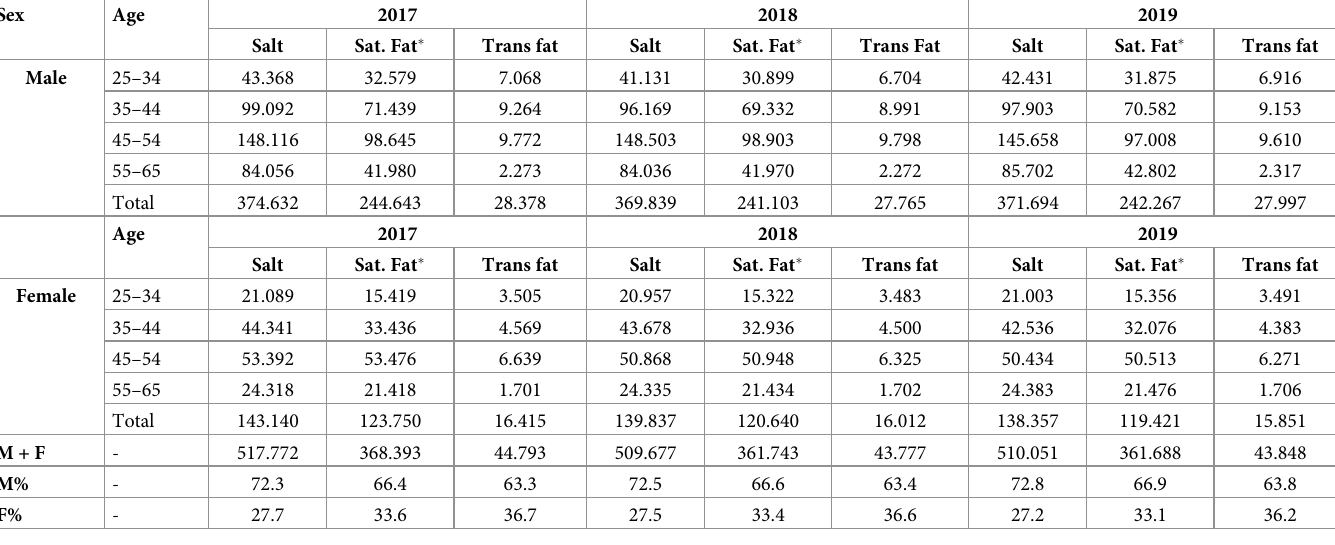
Table 4. Years of Life Lost (YLL) due to premature death by sex and age